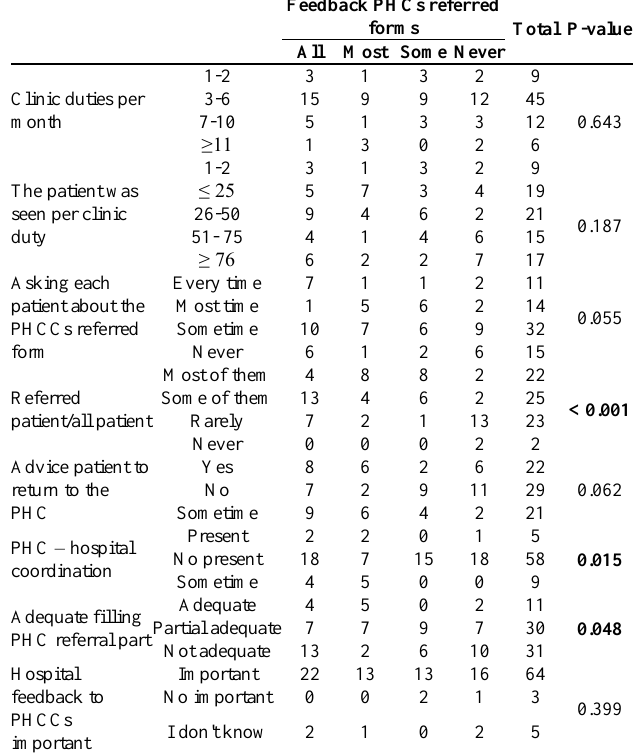
Table 5: Association between feedback PHCs referred forms